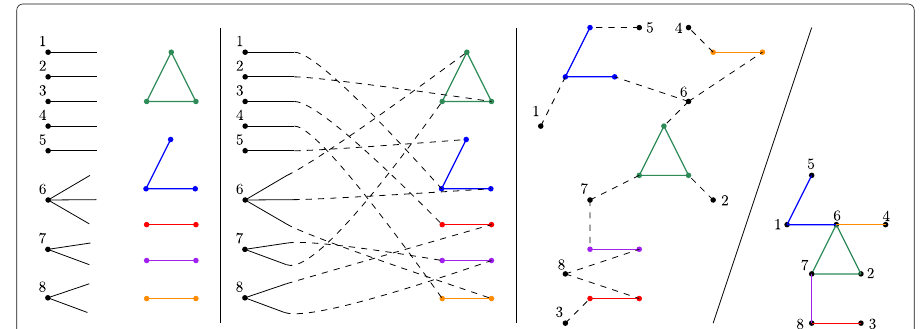
Fig. 1 A small example for constructing the RIGC model. From left to right, we see each step of the construction. Leftmost, we represent the list of community graphs in different colors, and the individuals by the numbered vertices; the number of stubs drawn for each individual corresponds to the number of membership tokens. The second subfigure represents the matching, with the imaginary edges drawn dashed. An imaginary edge between an individual and a vertex in a community means that one of the tokens of that individual was matched with that community role. The third subfigure is simply a redrawing of the second for the sake of clarity. Rightmost, we see the resulting RIGC, after the imaginary edges have been contracted